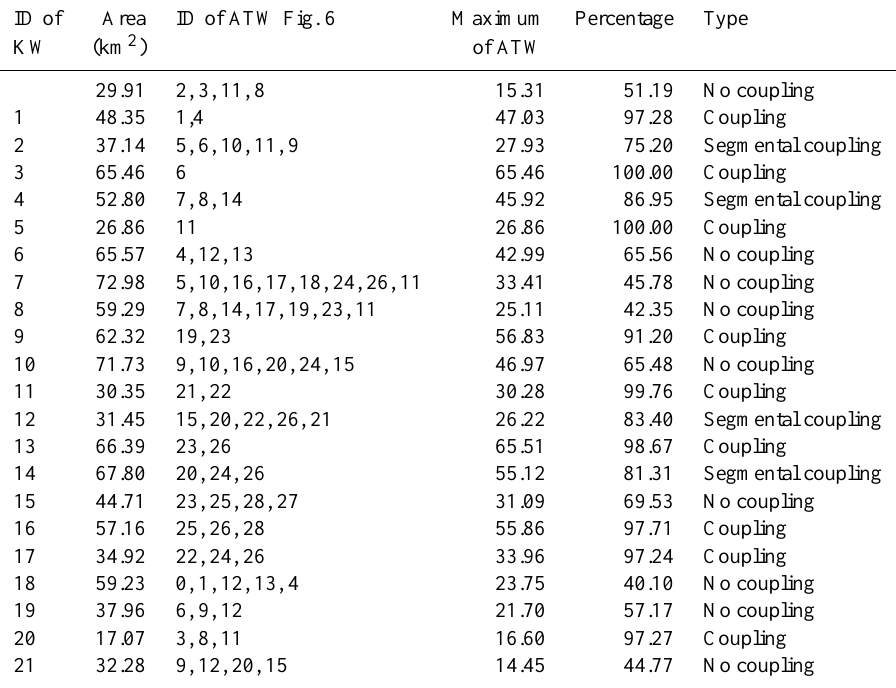
Table 3. Evaluation of the spatio-superimposed relationship between karst watersheds (KW) and auto-delineating topographic watersheds (ATW). ID of Area ID of ATW Fig. 6 Maximum Percentage Type KW (km 2